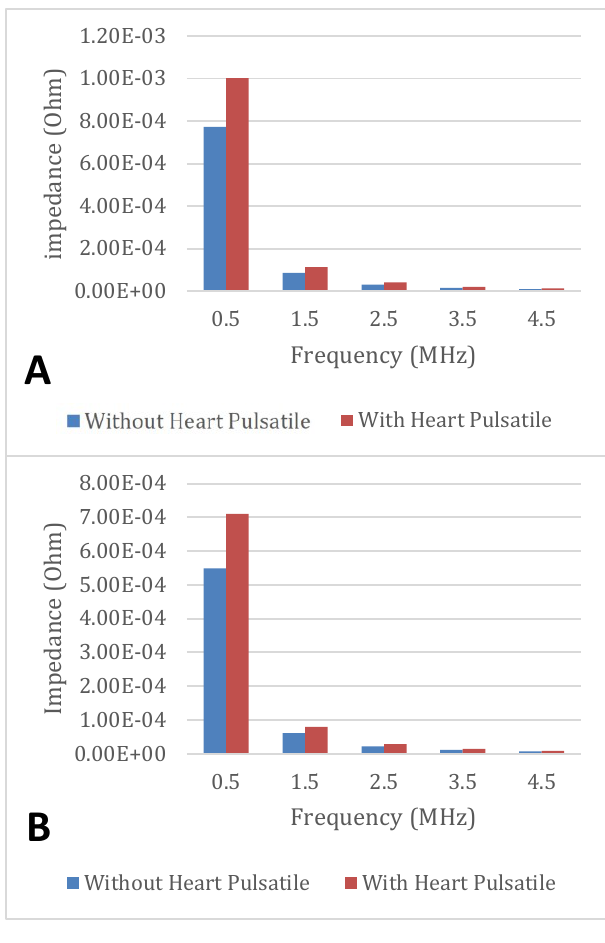
Fig. 9: Comparison between measuring the glucose level with and without heart pulsatile at different level of glucose concentration: A) 0 mg/dl, and B) 2000